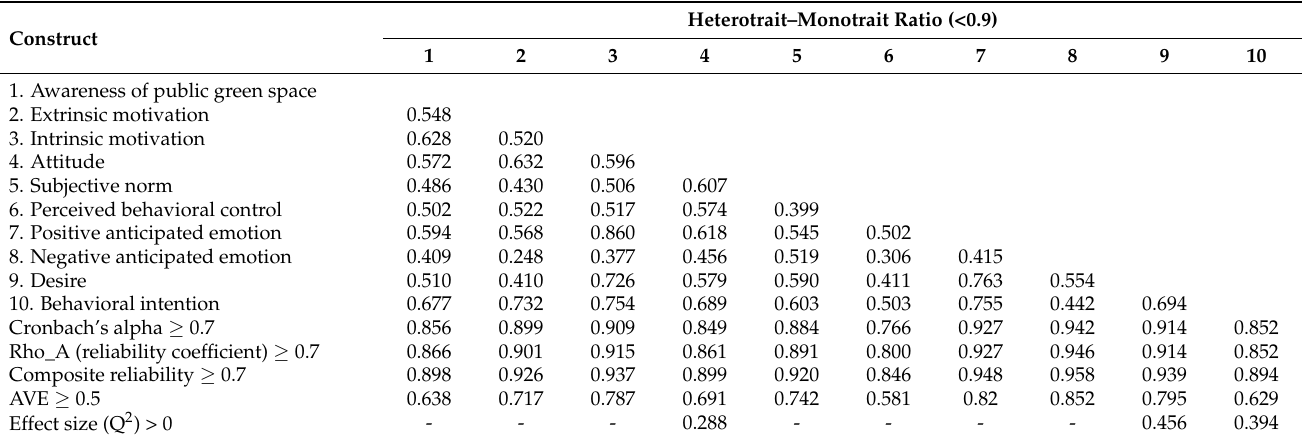
Table 1. Reliability and discriminant validity.